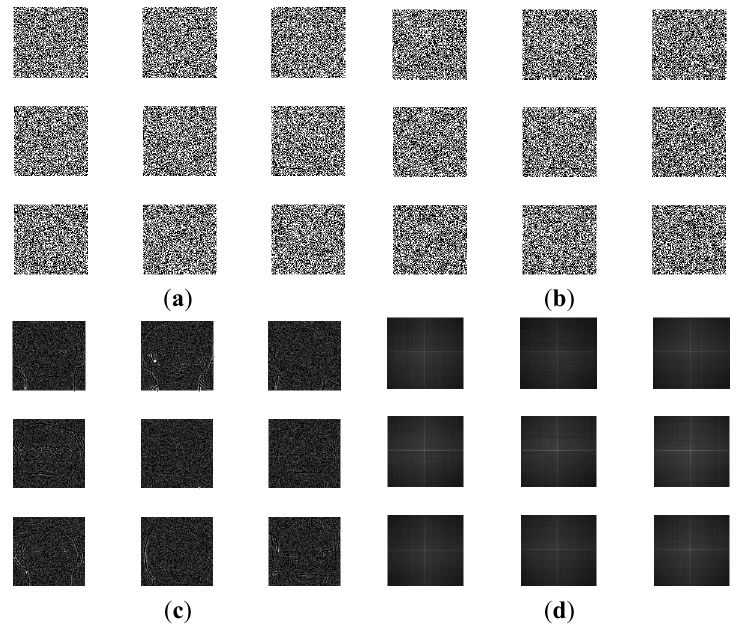
Figure 6. Encrypted versions of biometric faces in Figure 5 (from ORL dataset) for ( a ) CFR1 ( b ) CFR2, ( c ) homomorphic transform followed by salting and ( d ) homomorphic transform followed by random kernel convolution.